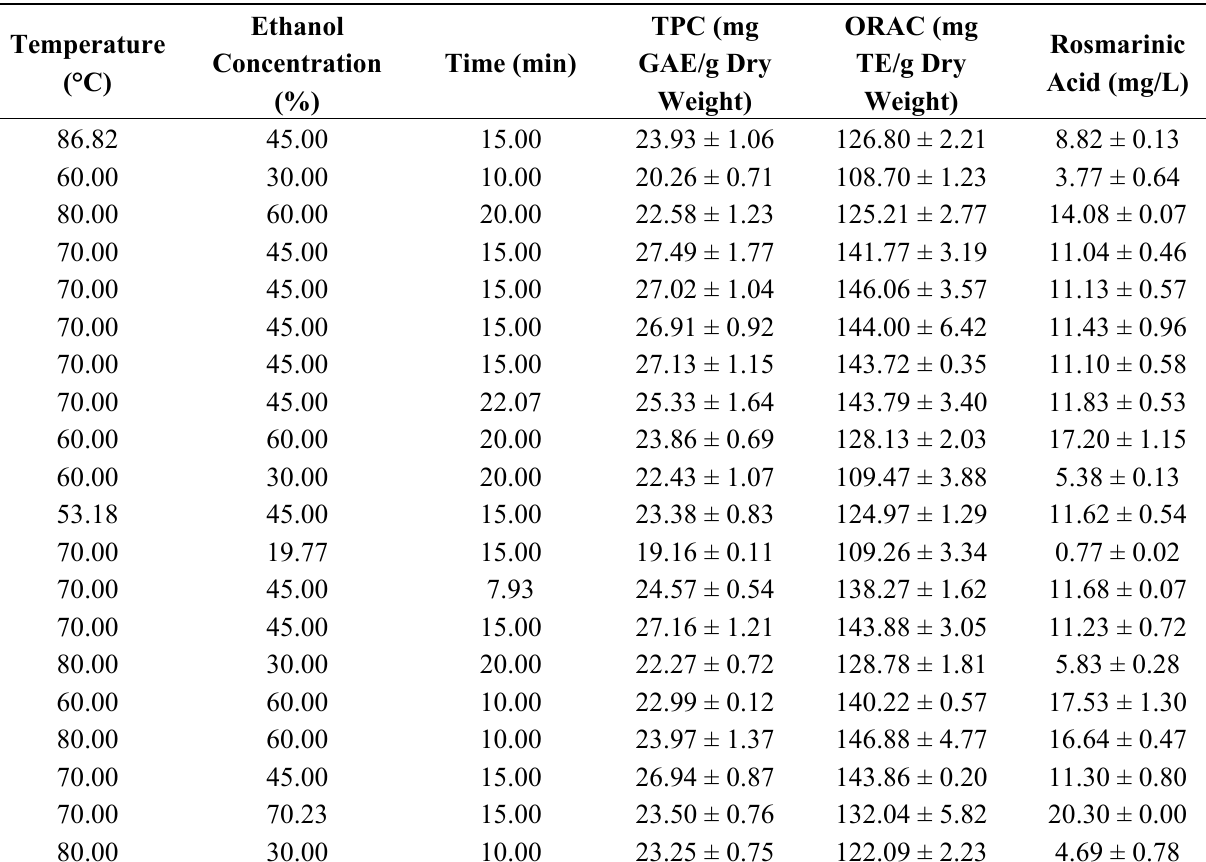
Table 3. Experimental design and responses for ethanolic extraction.